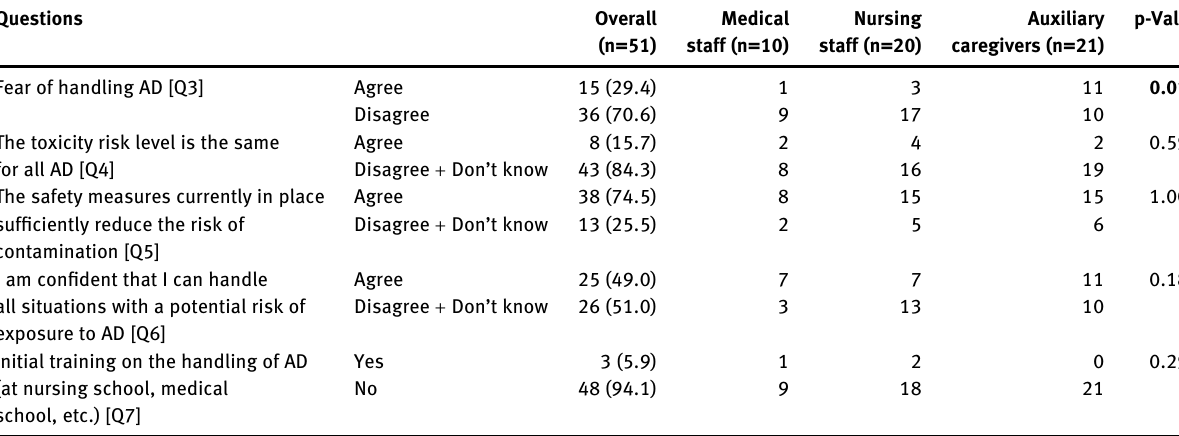
Table  B: Participants ’ characteristics.